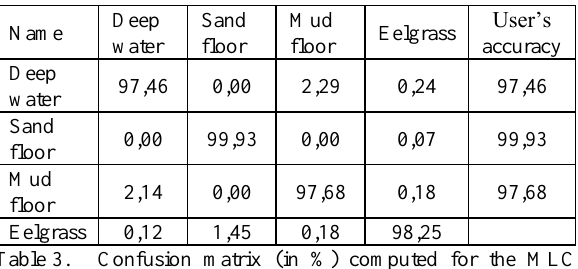
Confusion matrix (in %) computed for the MLC classified image produced from the Pix4D RGB mosaic of Shediac Bay.